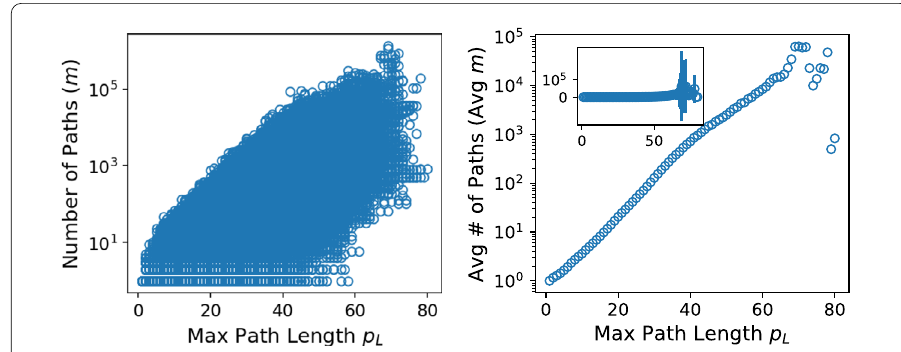
Figure 11 Maximum path length against the log of the number of paths per pair of source and target ports (left) as well as the log of the average number of paths (right, main plot) and including the amount of variation measured by one standard deviation (right, inset plot). As the maximum path length between a pair increases, so does the average number of paths between pairs with that maximum path length. An intuitive explanation for this trend is that longer minimum-route paths are concatenations of shorter minimum-route paths between intermediate source and target pairs (e.g. the loop on line 12 of Algorithm 1) that are all interchangeable. This implies that the number of paths between a pair with large maximum path length is a function of the product of the number of minimum-route paths at smaller lengths, and so the number of paths grows much more quickly than the maximum path length. However, at the highest maximum path lengths this trend does not hold. We attribute this to the fact that the very longest paths are likely to appear between ports that are not well-connected, thus there are few (perhaps only 1) viable minimum-route paths between some of these pairs, dragging the average down. Put another way: very long paths usually occur between poorly connected nodes, meaning they are more likely to be unique or few in number